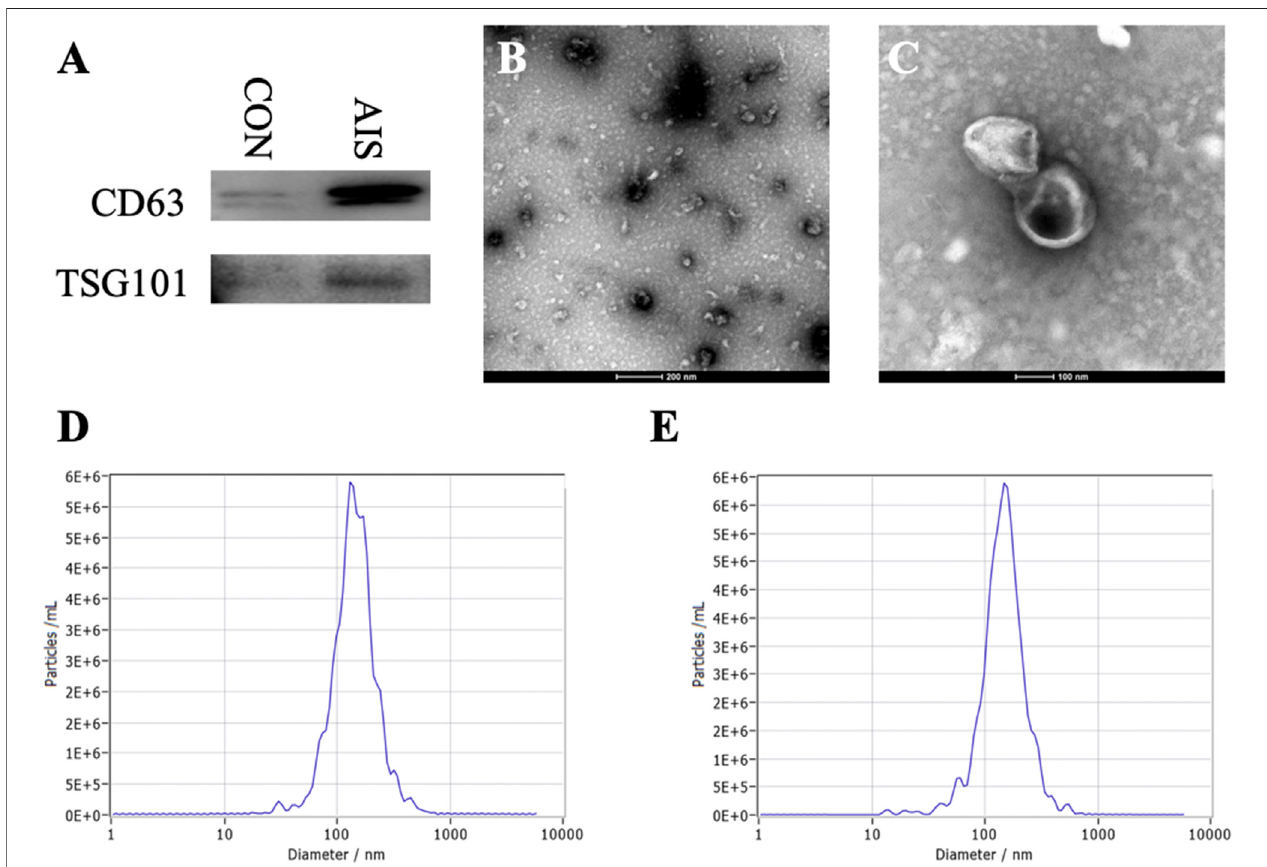
FIGURE 1 | Identi fi cation and characterization of plasma exosomes. (A) Detection of CD63 and TSG101 as exosome markers by western blot. (B , C) Representative images of transmission electron microscopy. (D , E) Representative size of exosomes from controls and AIS patients, respectively.